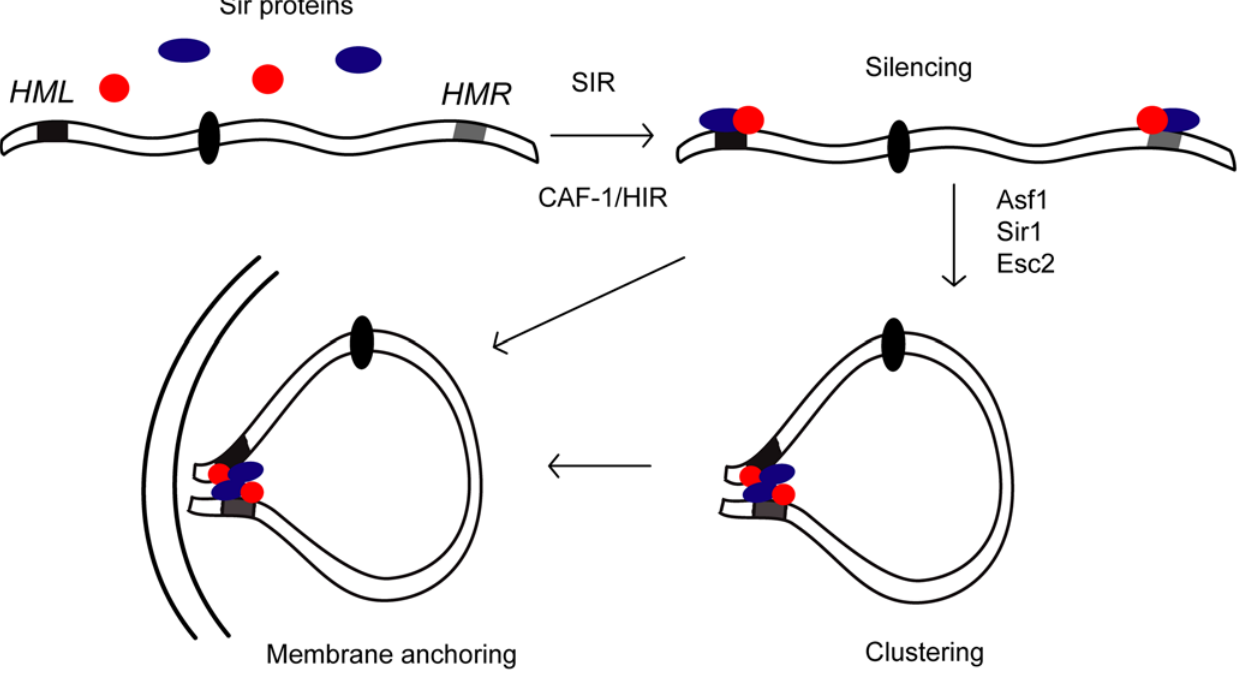
Figure 9. Clustering of silent chromatin. In the absence of silencing proteins, depicted as colored circles, HM -loci ( HML - black rectangle; HMR - gray rectangle) are not silenced and they do not form clusters. Upon expression, silencing proteins are available throughout the nucleus and can become recruited to the HM silencers, independent of their sub-nuclear position. Heterochromatin is formed and silencing is established. Once these loci are silenced, they obtain the ability to form clusters that can also contain telomeres. Silent clusters create sub-nuclear compartments in which there is a high local concentration of silencing proteins available for recruitment to loci located within the cluster only. Membrane association of silenced loci will anchor clusters or unclustered loci to the nuclear periphery. Loci located outside heterochromatin compartments have no access to silencing proteins and are not silenced. In this model clustering, membrane anchoring as well a genomic proximity of HM loci to telomeres will all contribute to formation of sub-nuclear compartments that are enriched in silencing complexes, which will facilitate heterochromatin formation at resident loci.